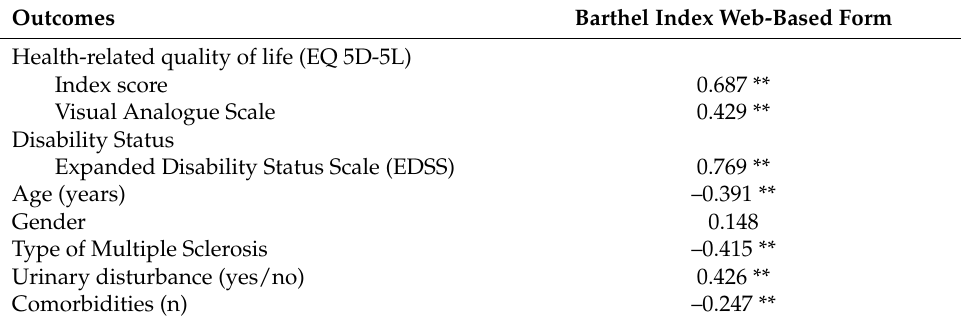
Table 3. Spearman correlations of the web-based form of the Barthel index total score with patients’ health-related quality of life, as well as with their disability status, age, and clinical